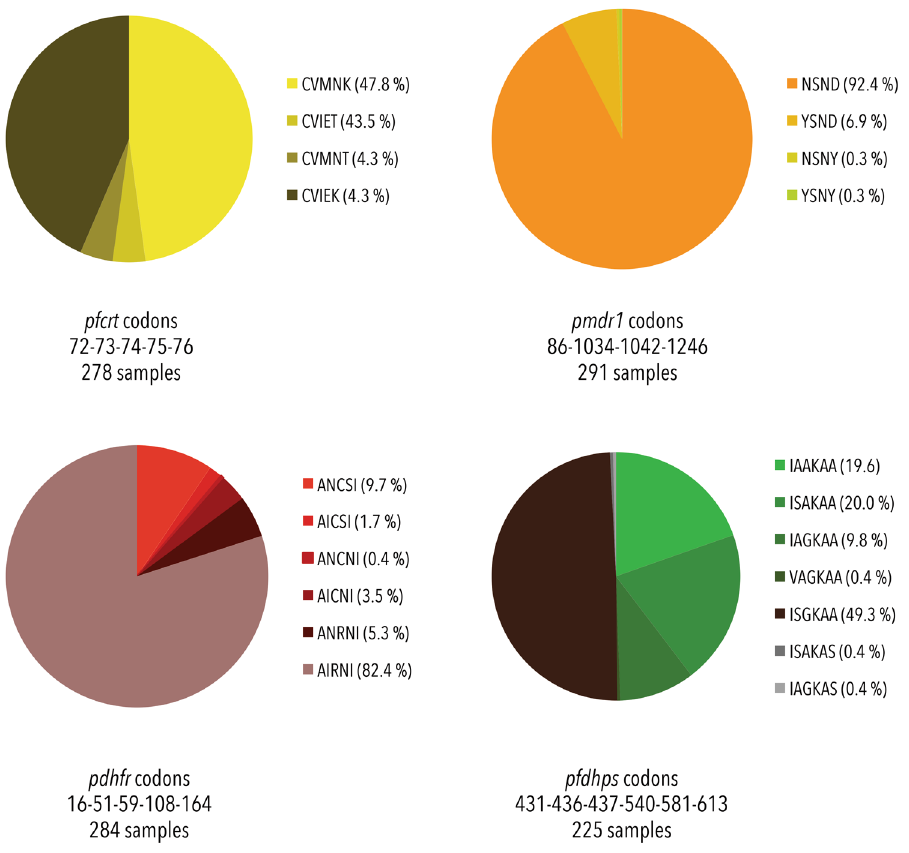
Figure 4. Haplotype distributions. Four genes were analysed for the distribution of different haplotypes, due to the relevance of certain haplotypes in conferring different levels of tolerance/resistance towards various antimalarial drugs. The figure illustrates the distribution of haplotypes (mixed infections omitted) found in pfcrt , pfmdr1 , pfdhfr and pfdhps . Complete haplotypes could be assigned to 278 samples for pfcrt , 291 samples for pfmdr1 , 284 samples for pfdhfr and 225 samples for pfdhps